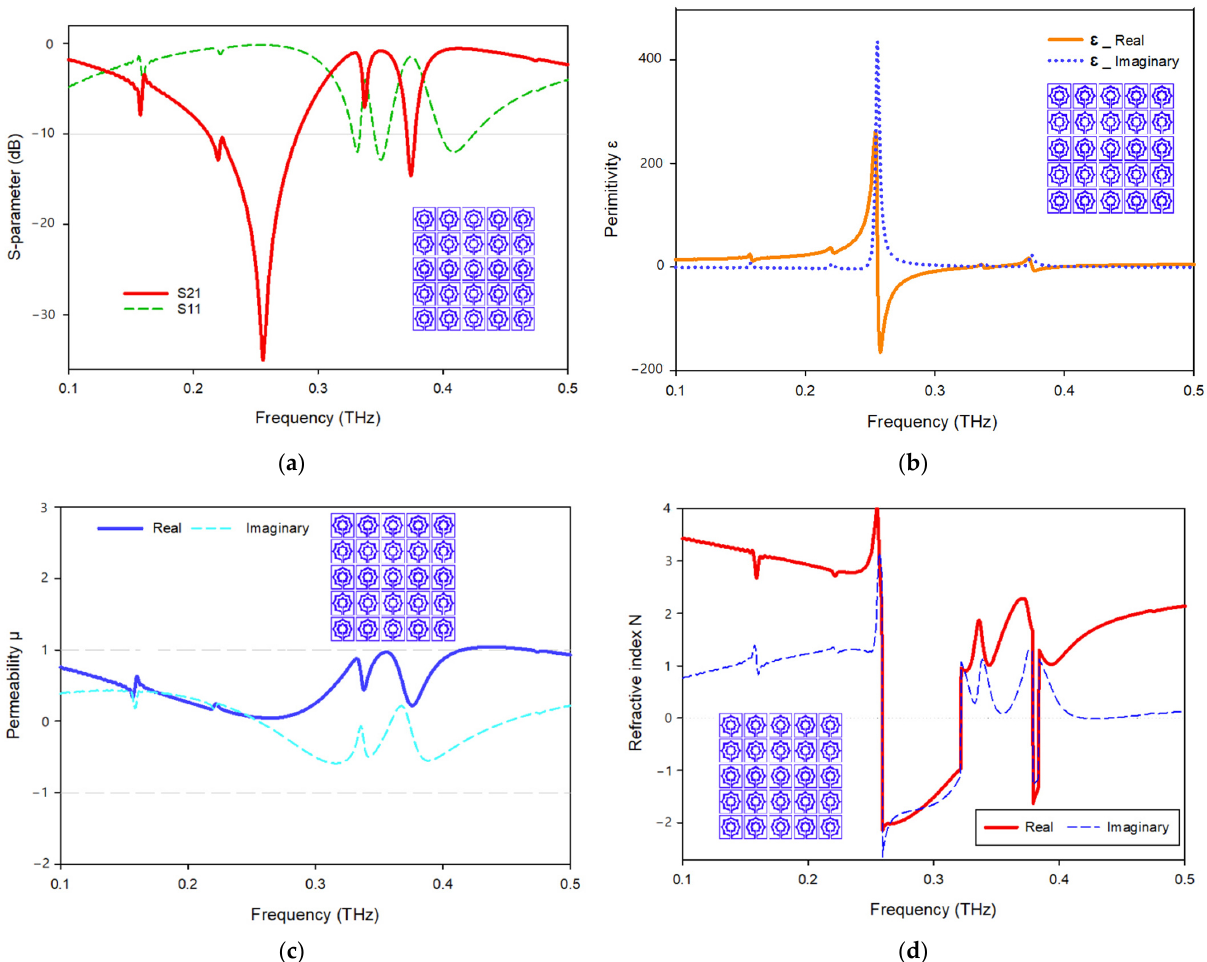
Figure 17. Effective parameters of the 5 × 5 array structure: ( a ) scattering parameters; ( b ) permittivity; ( c ) permeability; ( d ) refractive index.